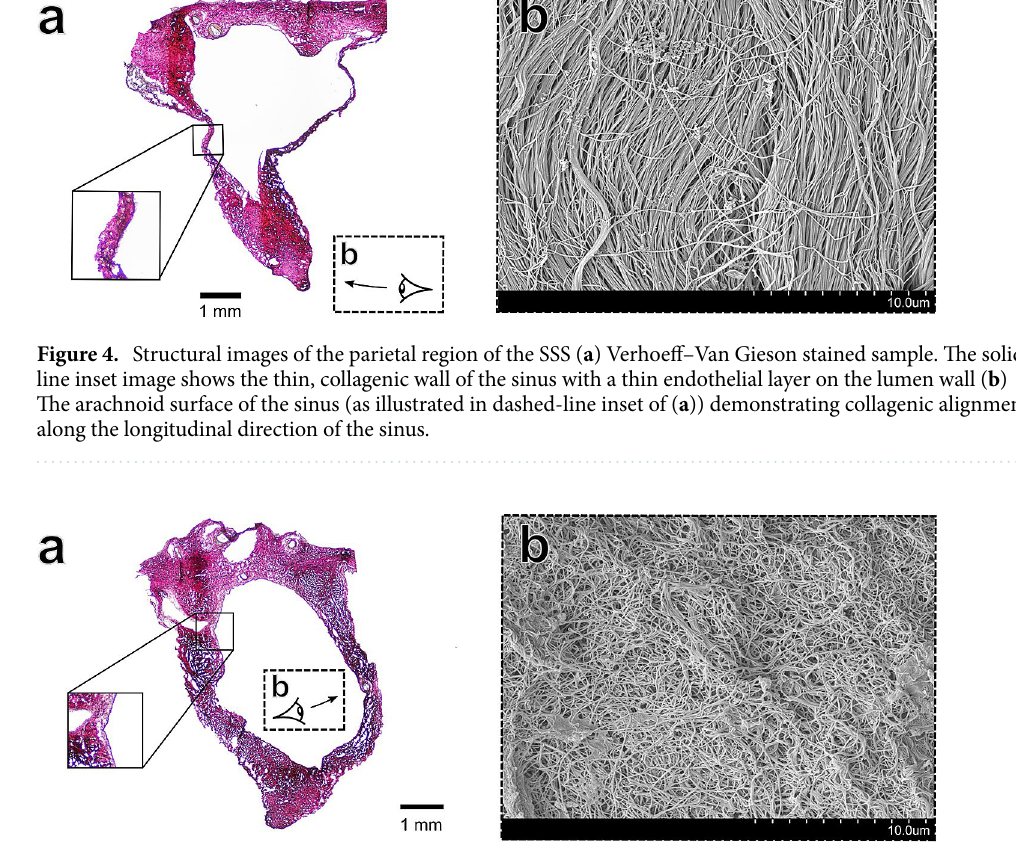
Figure 5. Structural images of the occipital region of the SSS ( a ) Verhoeff–Van Gieson stained sample. The solid-line inset image again demonstrates the thin endothelial later of the dural sinus tissue ( b ) The surface of the occipital region lumen wall (as illustrated in dashed-line inset of ( a )) depicting seemingly random collagenic alignment, with the endothelial layer removed from the maceration